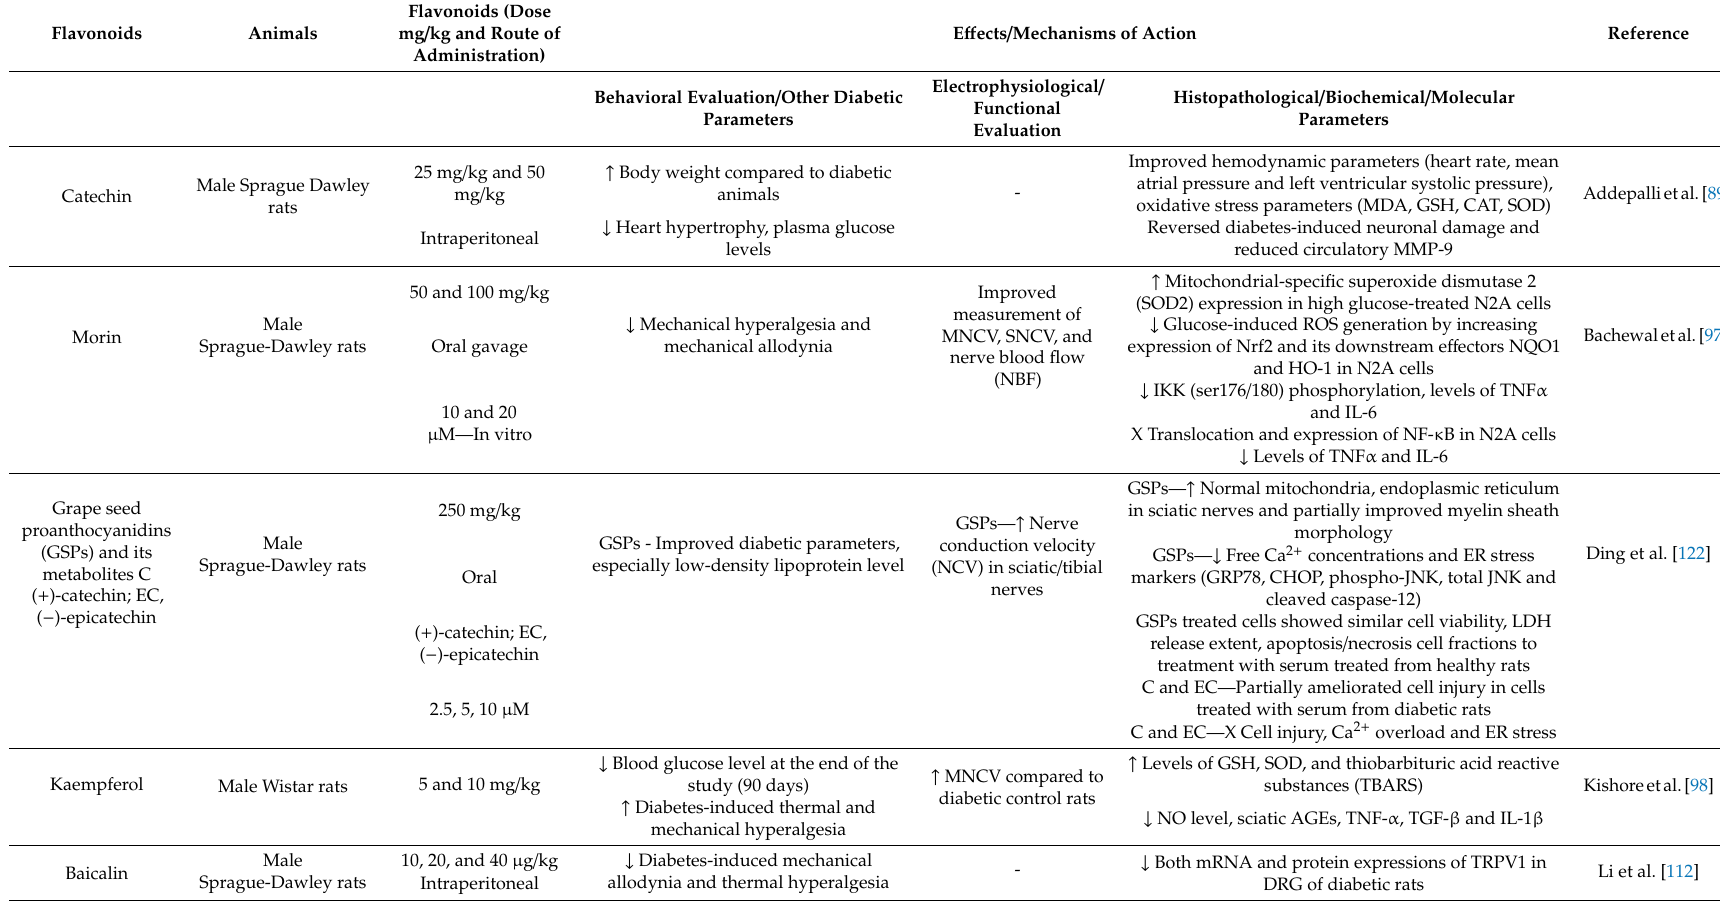
Table 4. E ff ects of flavonoids on diabetic painful neuropathy